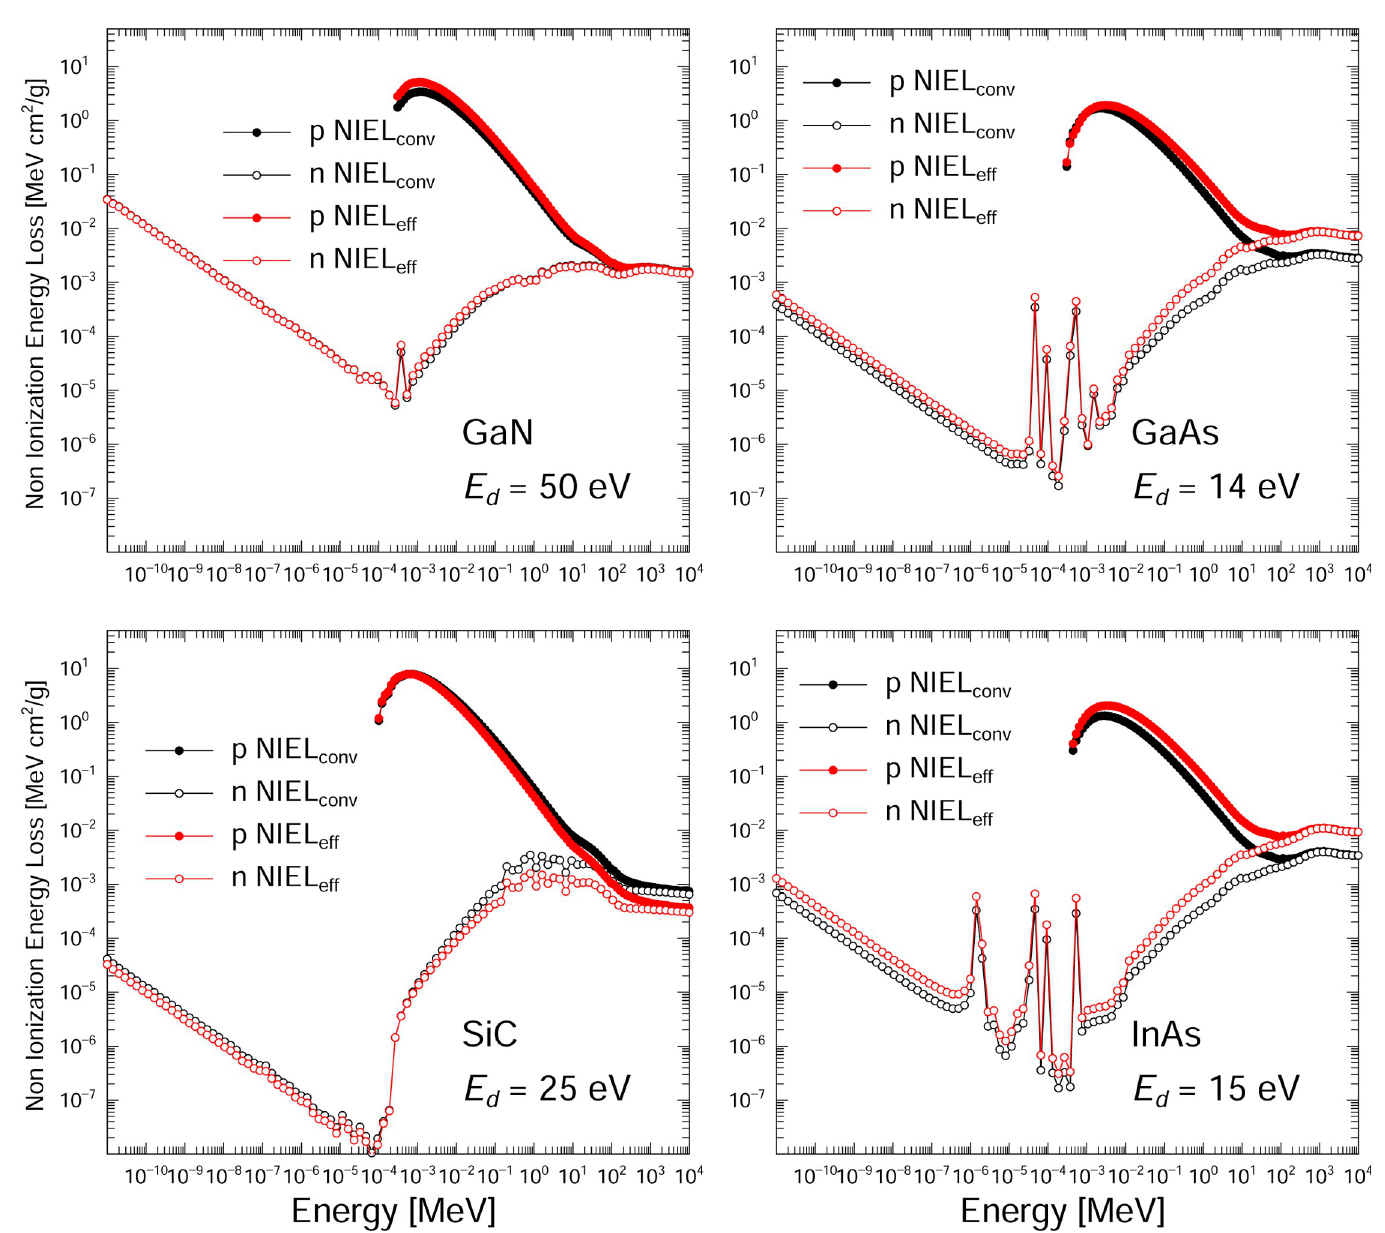
Fig 5. NIEL eff and NIEL conv values for the proton and neutron irradiation of semiconductors as calculated using the PHITS code.